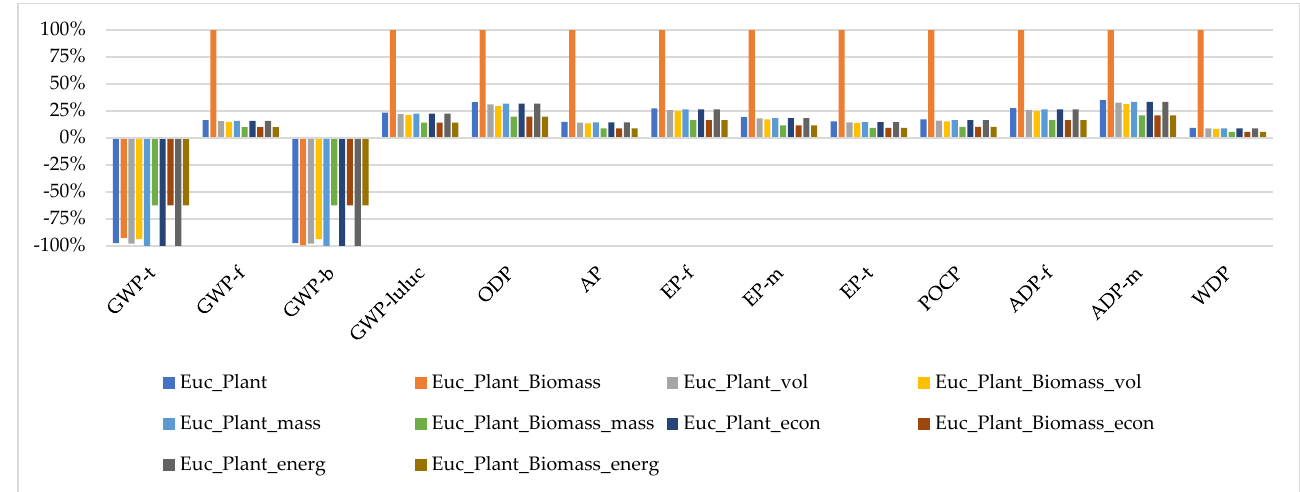
Figure 3. Relative environmental impacts of biomass and roundwood from MP_Plant scenario.